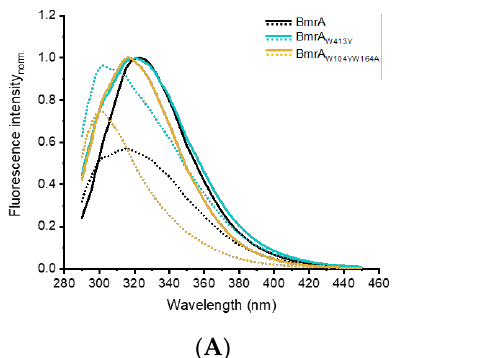
Figure 4. Transport activity of BmrA wt and single Trp variants. The three Trp residues (W104, W164, and W413) of BmrA were individually replaced by Ala, Tyr, or Phe, respectively (see Fig- ure 1A). The Hoechst transport activity of inverted vesicles containing the respective BmrA variants was determined. Inverted vesicles missing BmrA were used as negative control (pET303). Addition- ally, the results for the double mutant W104YW164A, where only the Trp residue of the NBD is present, are shown. Data show a triple determination of two independent, inverted membrane ves- icle preparations each (±SD).